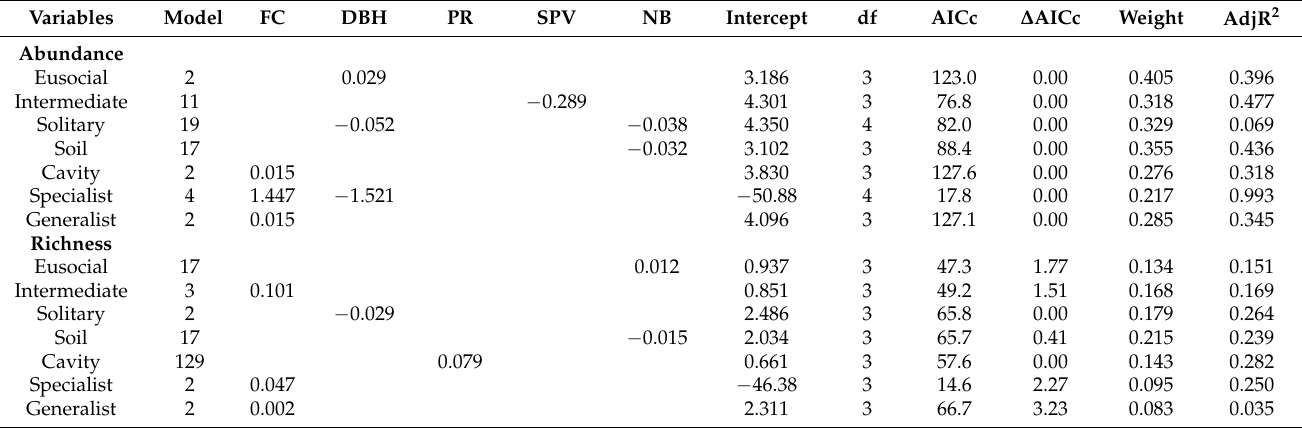
Table 3. Parameter estimates of a generalized linear model, explaining abundance and richness of bee guilds in urban green area (UGA) in Campos dos Goytacazes, RJ, Brazil. Inside UGA: flower cover in m 2 (FC), diameter at breast height (DBH), plant richness (PR), surrounding percentage of paving (SPV) and the number of buildings with more than three floors (NB).